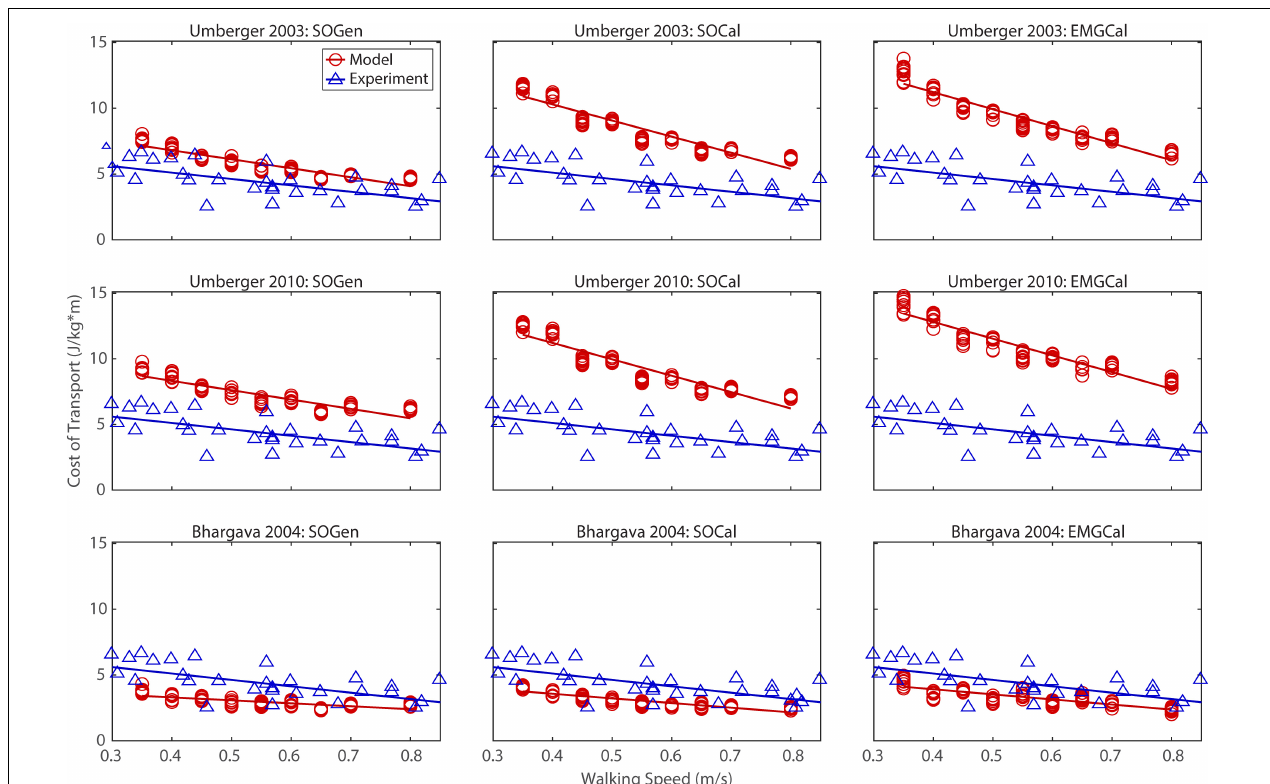
FIGURE 2 | Comparison of model predicted (red circles) and experimentally measured (blue triangles) cost of transport as a function of walking speed. Model predictions include all possible combinations of three musculoskeletal models possessing different levels of personalization (columns) and three metabolic cost models (rows). Experimental measurements were obtained from Finley and Bastian